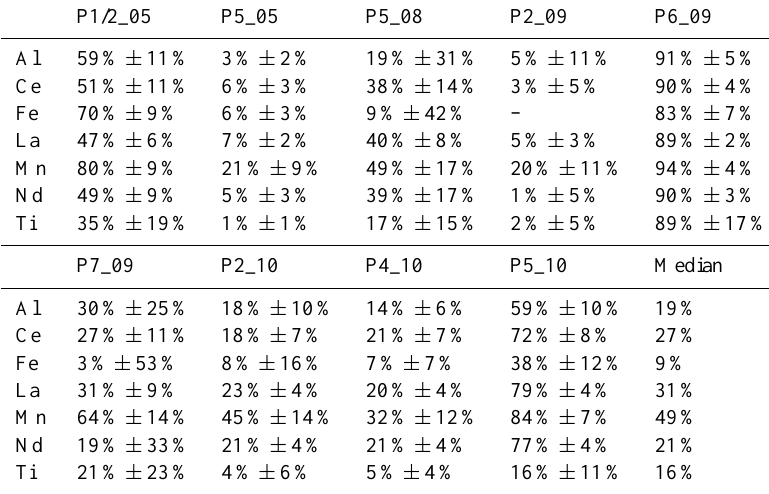
Absolute uncertainties ( ± ) are computed using Eq. 7 for each rain sample. Table 4b. Solubility (%) in possible contaminated rainwater